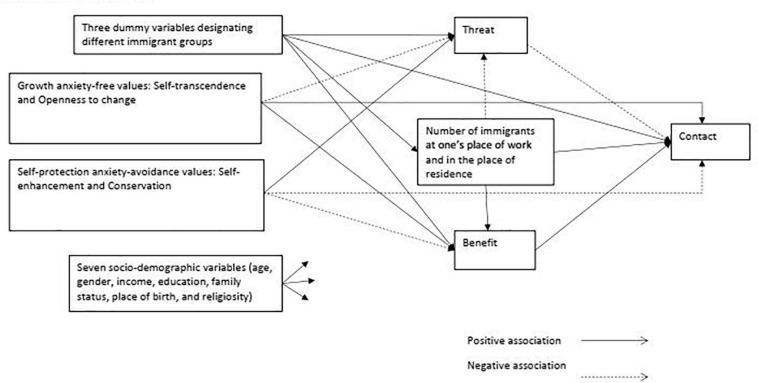
The research model.